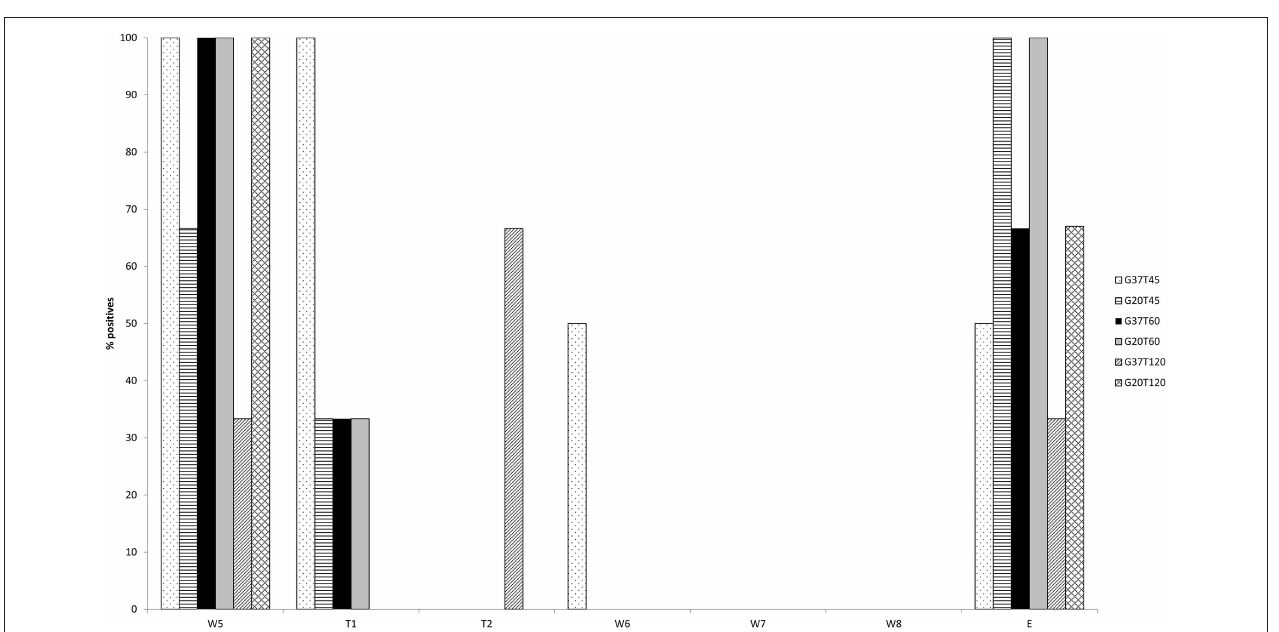
two animals received embryos for which the second pool was negative while animal 1047 received a paired embryo sample for which the second pool scored doubtful. The two sentinel animals (identification number: 1056 and 1070) remained negative on ELISA and RT-qPCR for the complete duration of the experiment (i.e., 80 days post-transfer; dpt). The three recipient cows became viremic at the same time, namely 7 dpt and with